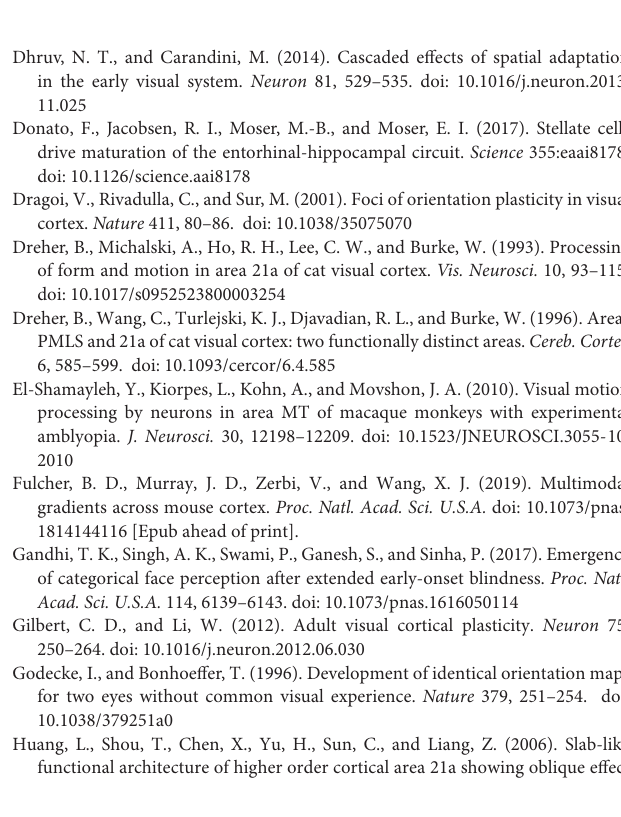
FIGURE S1 | A comparison of the effect of 3 days’ MD between area 17 (A,B,E,F) and area 21a (C,D,G,H) in the same kitten. (A,C) Each row shows orientation differential maps evoked by monocular stimuli. Top: non-deprived eye. Bottom: deprived eye. Each column shows orientation differential maps with varying-orientation stimuli. Left: 0–90 ◦ . Right: 45–135 ◦ . (B,D) Orientation tuning is visualized by orientation polar maps, in which different colors represent the preferred stimulus orientation, and the gray scale represents the tuning strength of each pixel. Top: non-deprived eye. Bottom: deprived eye. (E,G) The distribution of pixelwise differences of preferred orientation between the two eyes. (F,H) The distribution of the ODI of pixels in the dashed regions in (e,m), respectively. FIGURE S2 | A comparison of the effect of 7 days’ MD between area 17 (A,B,E,F) and area 21a (C,D,G,H) in the same adult animal. (A,C) Each row shows orientation differential maps evoked by monocular stimuli. Top: non-deprived eye. Bottom: deprived eye. Each column shows orientation differential maps with varying-orientation stimuli. Left: 0–90 ◦ . Right: 45–135 ◦ . (B,D) Orientation tuning is visualized by orientation polar maps, in which different colors represent the preferred stimulus orientation, and the gray scale represents the tuning strength of each pixel. Top: non-deprived eye. Bottom: deprived eye. (E,G) The distribution of pixelwise differences of preferred orientation between the two eyes. (F,H) The distribution of the ODI of pixels in the dashed regions in (e,m),